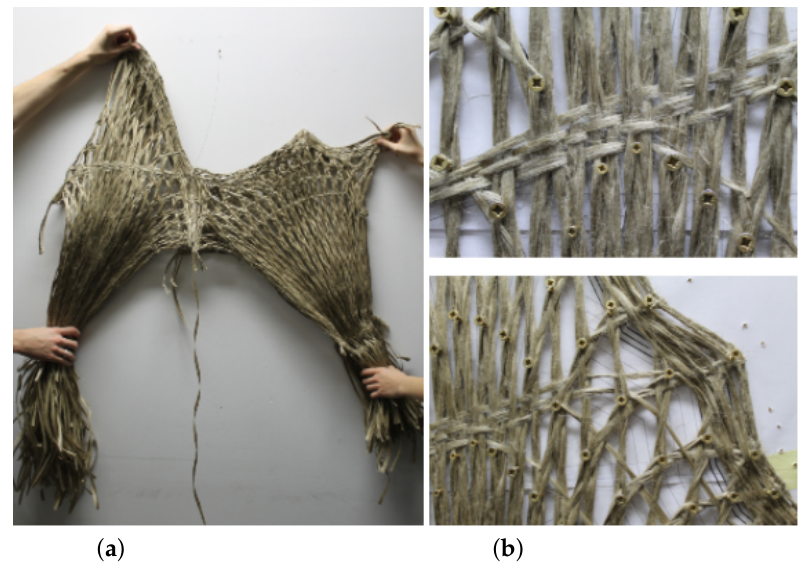
Figure 14. The laced chair prior to resin infusion ( a ) All four legs stitched together. ( b ) Details of the various reinforcement strategies in the final prototype.